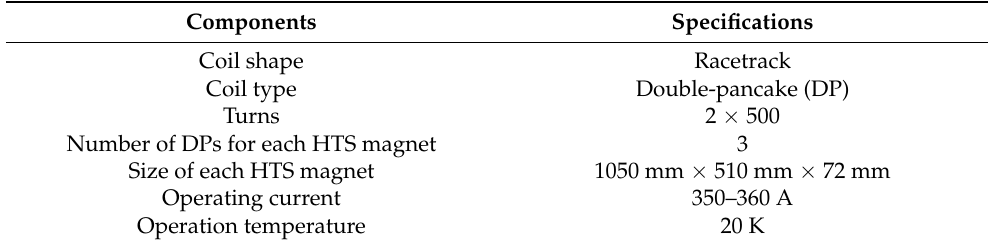
Table 1. Parameters of the HTS magnet for the